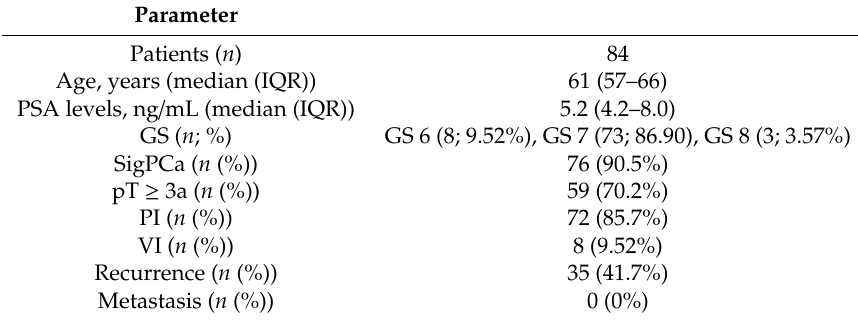
Table 1. Demographic, biochemical and clinical parameters of the patients who underwent radical prostatectomies (Cohort 1).